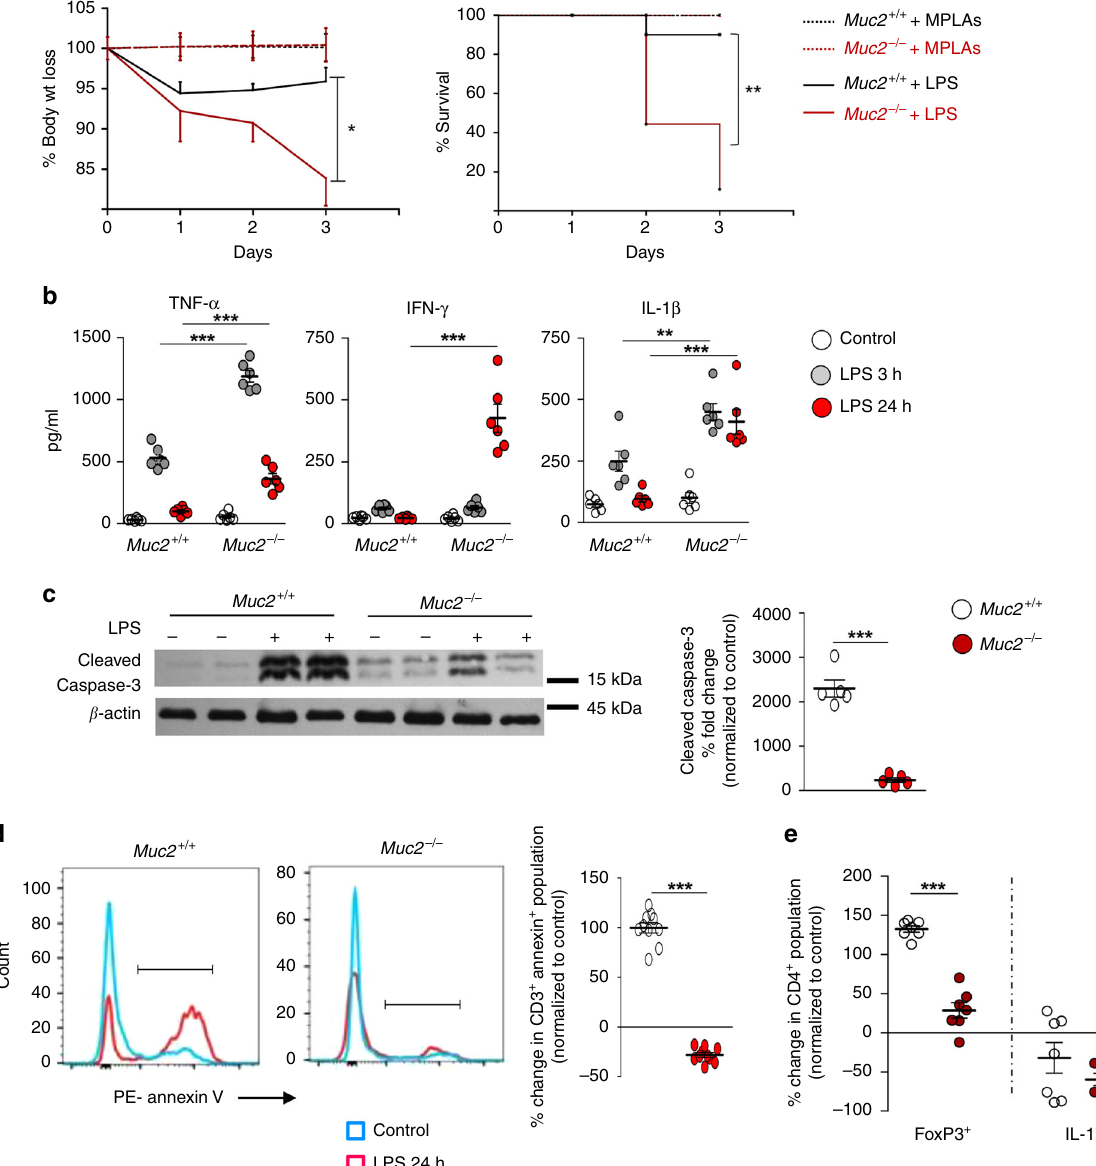
Fig. 2 Muc2 − / − mice are highly susceptibility to sepsis. a Comparative sensitivities of Muc2 − / − littermates to sepsis following intraperitoneal administration of LPS at 5 mg/kg body weight. Untreated animals received a similar dose of monophosphoryl lipid A (MPLAs). LPS caused higher body weight loss and mortality in Muc2 − / − littermates ( n = 8). Representative data from four independent experiments; paired one-way ANOVA. b Comparative analysis of pro-in fl ammatory cytokines levels at different time points in the blood following LPS challenge indicating unregulated heightened immune response in Muc2 − / − littermates ( n = 6). Representative data are from three independent experiments: Student ’ s t test. c and d LPS inoculation in Muc2 − / − show reduced levels of apoptotic splenocytes. c Representative immunoblot from four independent experiments demonstrating that unlike Muc2 + / + , splenocytes from Muc2 − / − littermates undergo attenuated apoptosis (cleaved caspase-3) 24 h post LPS challenge ( n = 5). Quantitative analysis represents values normalized to untreated group (paired Student ’ s t test). d Representative fl ow cytometry histogram and cumulative analysis of splenic CD3 + T-cells apoptosis showing signi fi cantly lower populations of Annexin-V-positive cells in Muc2 − / − as compared to Muc2 + / + littermates 24 h post LPS ( n = 10). Data are representative of three independent experiments, Student ’ s t test. e Reduced Tregs CD4 cell population in Muc2 − / − littermates following LPS challenge shows unregulated heightened immune response, whereas Th17 CD4 cell populations remains unchanged in both genotypes ( n = 7). Data are representative of three independent experiments, Student ’ s t test. * p < 0.05, ** p < 0.01, and *** p <